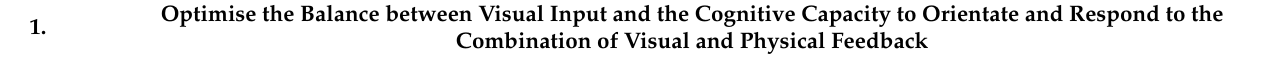
Table 1. Summary of relevant ergonomics in peripheral nerve